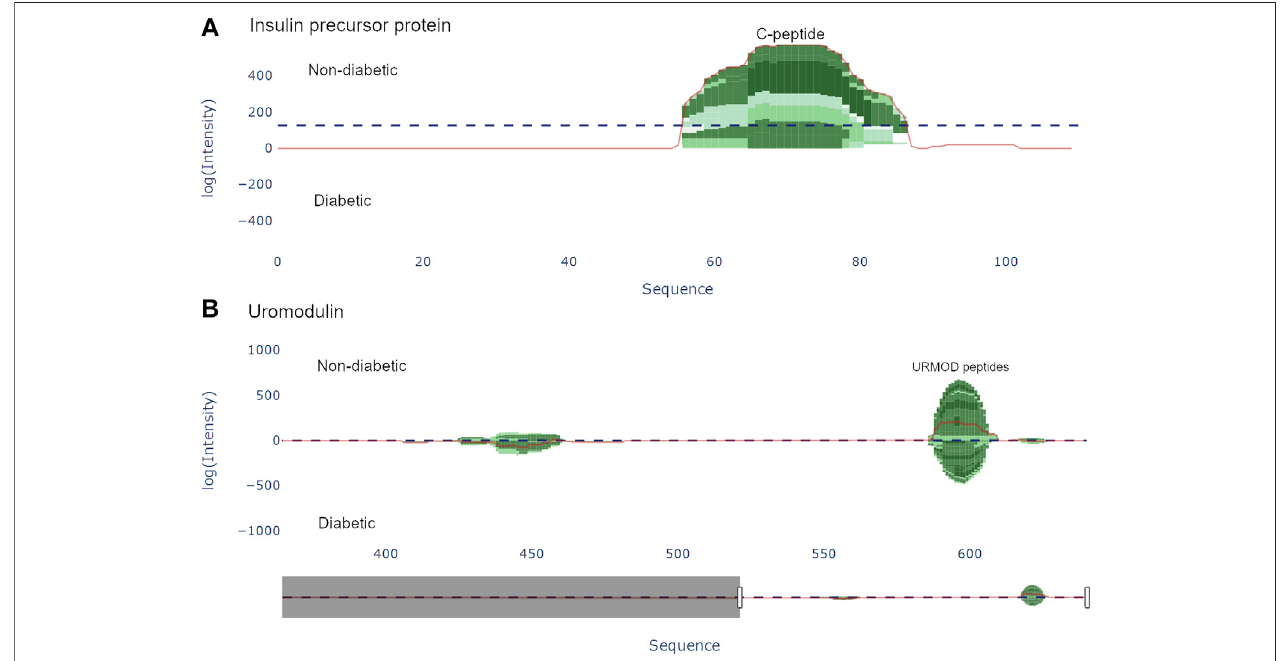
FIGURE3| Peptideviewofinsulinprecursorprotein(INS_HUMAN)anduromodulin(UROM_HUMAN). (A) TheC-peptide(57 – 87)fromtheinsulinprecursorprotein is present in group 1 (non-diabetic). (B) There are two distinct regions present in uromodulin. The second region (430 – 460) contains the peptides UMOD1-UMOD7 and was documented by Van et al. [Van et al. (2020)].